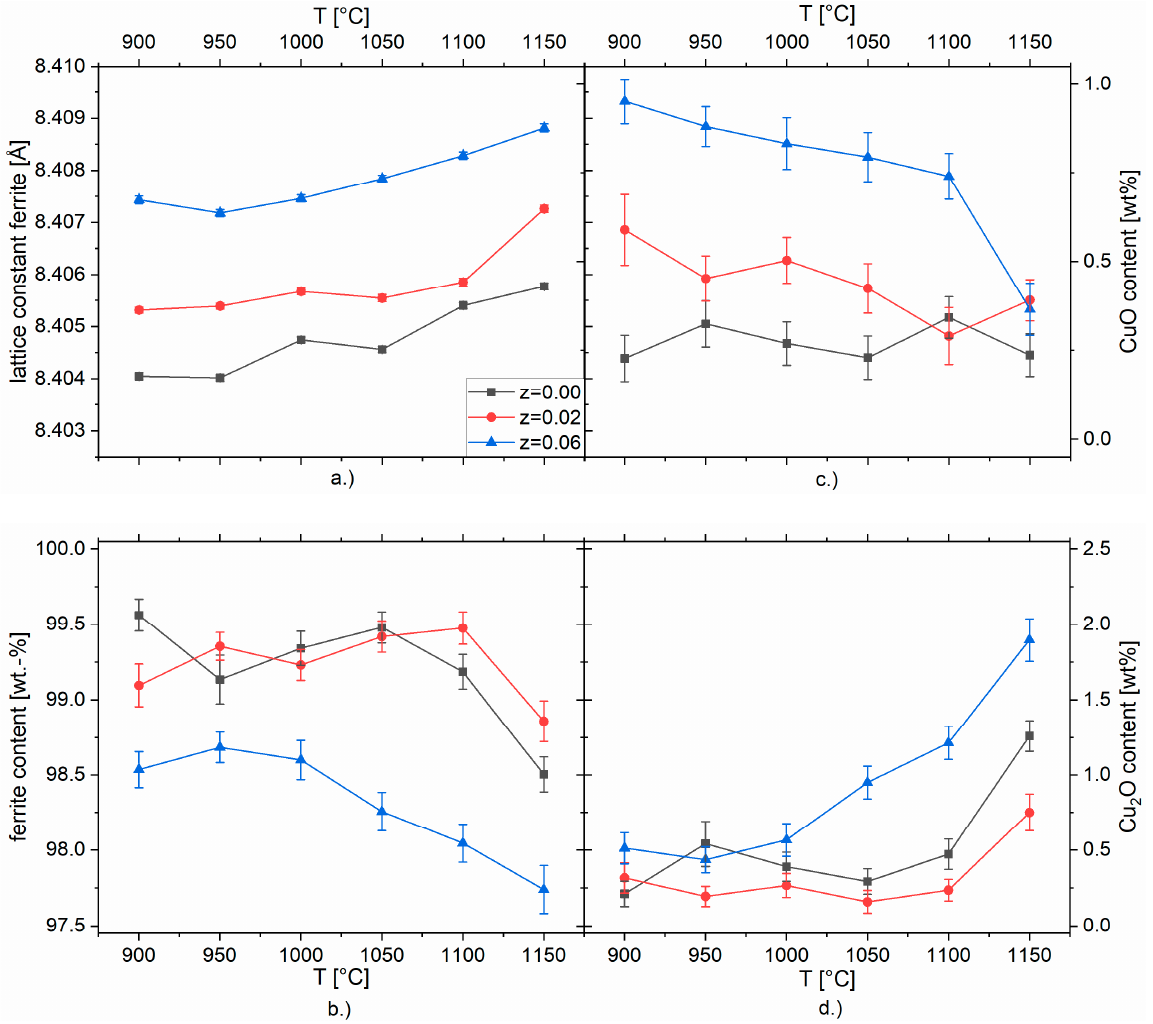
Figure 6. ( a ) Lattice parameters a 0 , ( b ) ferrite content, ( c ) CuO content, and ( d ) Cu 2 O content from Rietveld refinements for 0 ≤ z ≤ 0.06 vs. sintering temperature.